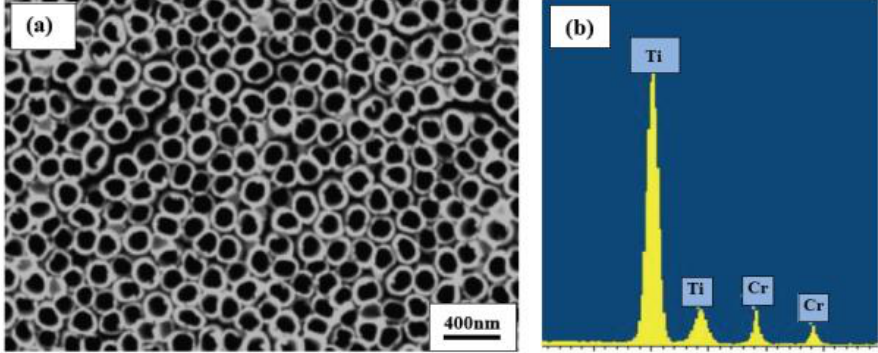
Figure 5. ( a ) Top-view SEM image of TiO NTs doped with Cr by the soaking method 2 ( b ) Energy Dispersive X-ray (EDX) results obtained at this surface indicate the presence